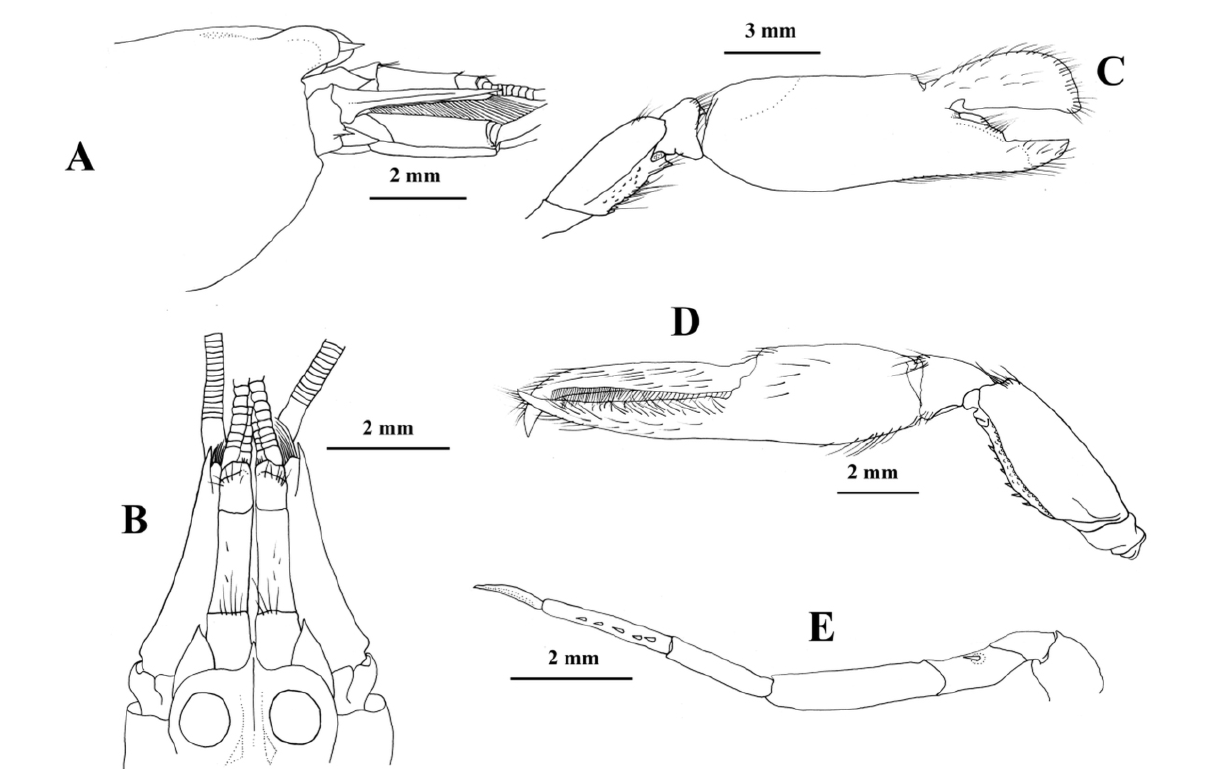
Figure 1. Alpheus platycheirus Boone, 1927, female. A , Frontal region, lateral; B , frontal region, dorsal; C , major cheliped, lateral; D , minor cheliped, lateral; E , fourth pereopod,